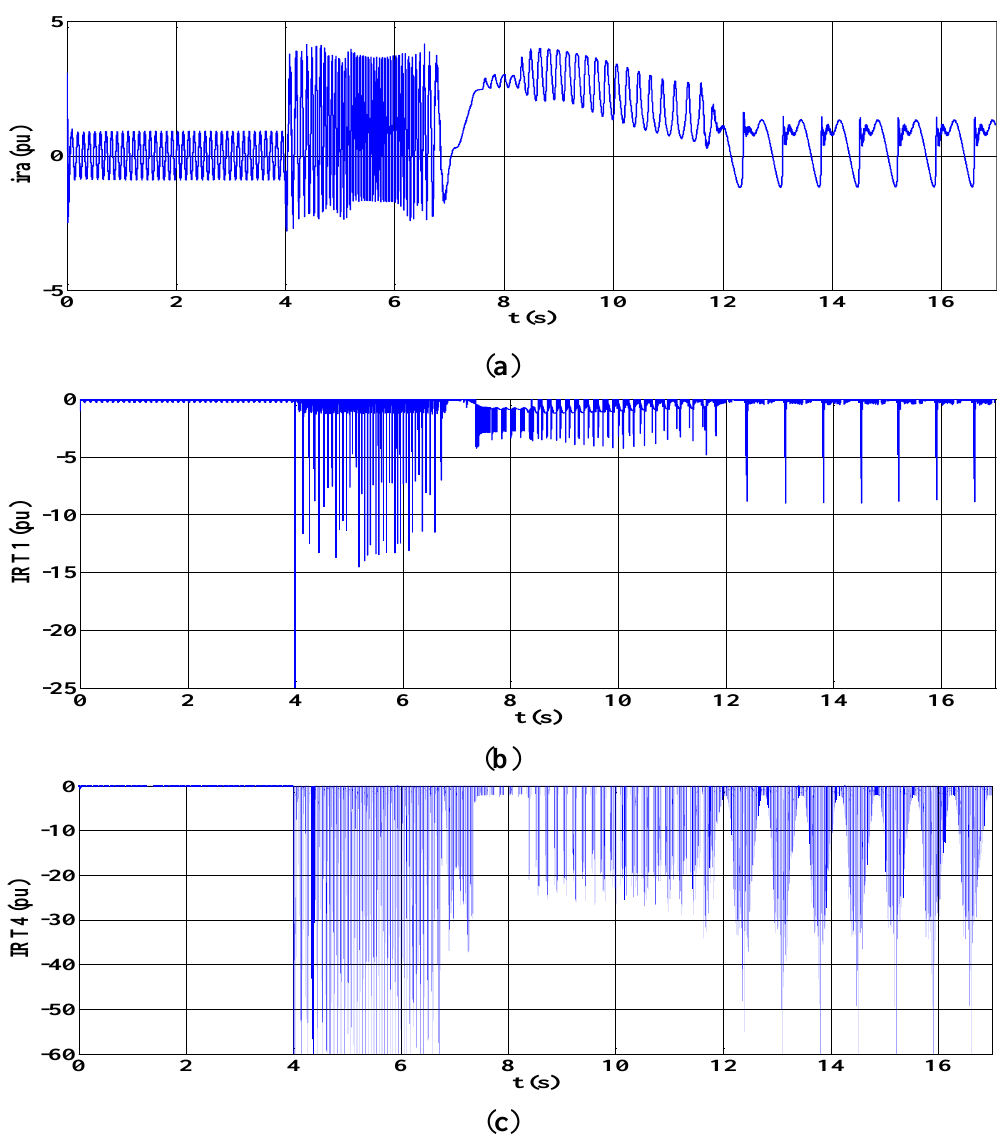
Figure 6. Waveforms of the characteristic variables of the RSC: ( a ) Rotor phase current i ra , ( b ) Current through IGBT (1), ( c ) Current through Insulated Gate Bipolar transistor (IGBT) (4) (short-circuit happens at t = 4 s for all waveforms).